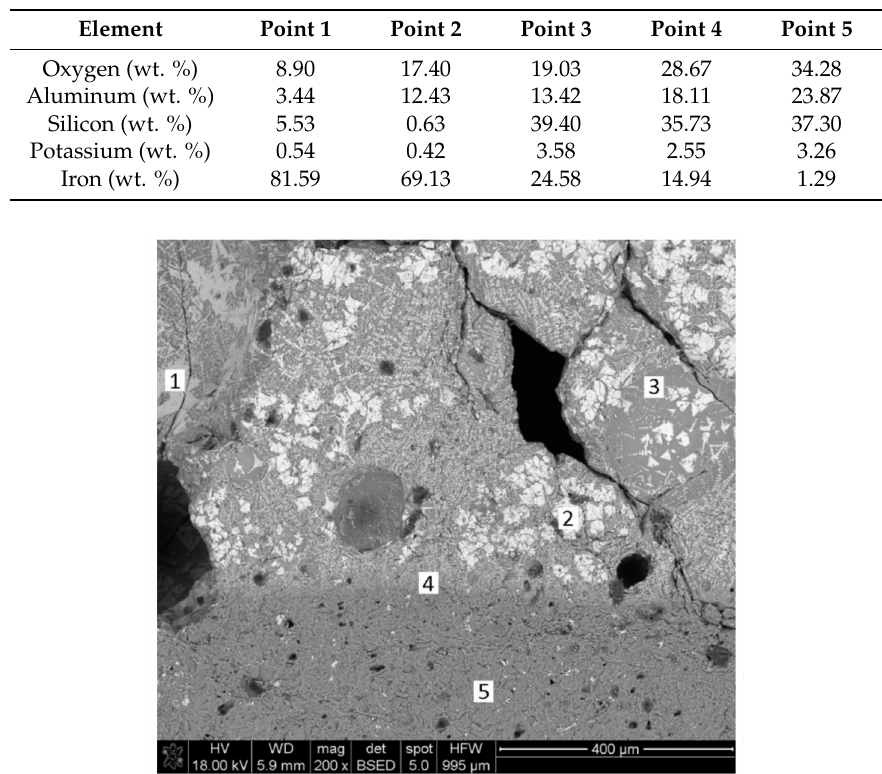
Figure 17. SEM-EDX for the sample